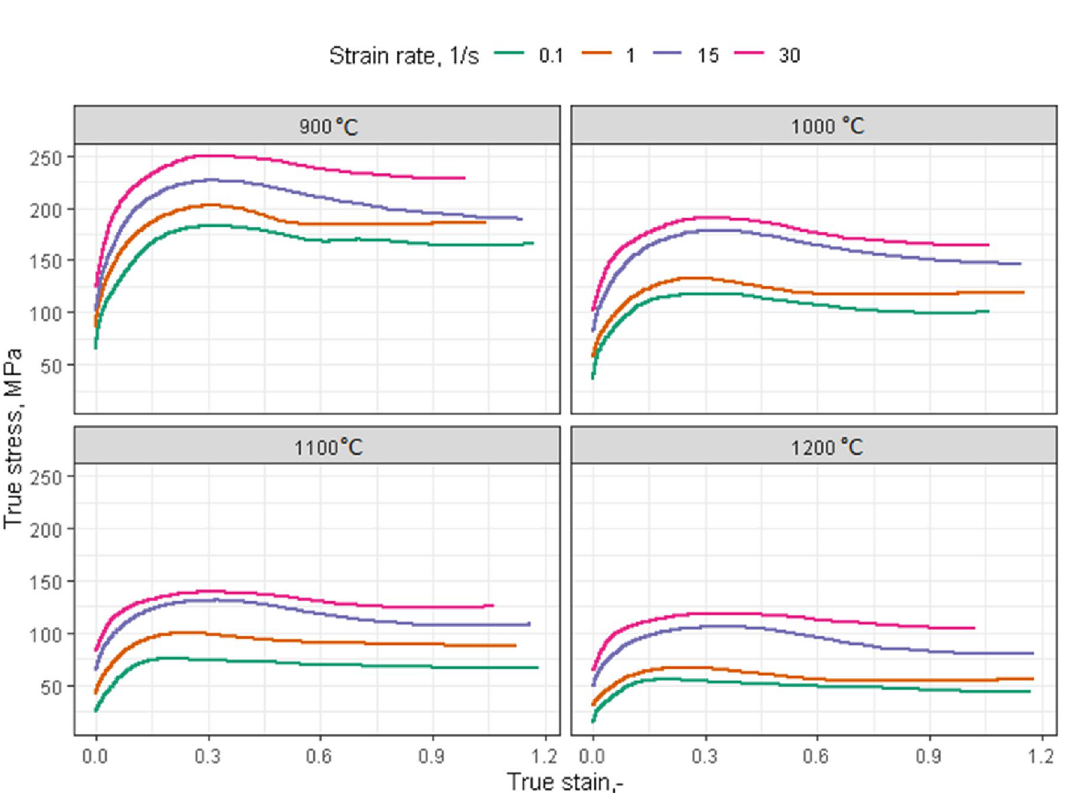
Fig. 2 Flow curves obtained experimentally for each temperature and strain